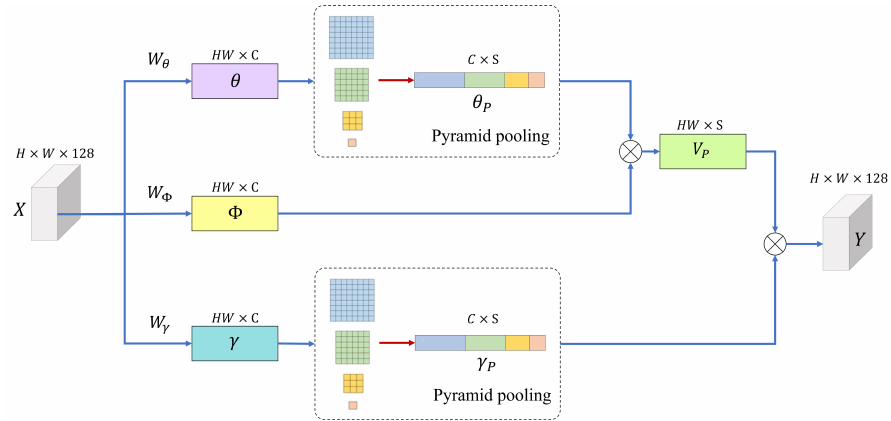
Figure 6. Structure of the asymmetric pyramidal non-local block with spatial pyramid pooling [88]. First, the input feature map X is converted to different embeddings, Φ , θ , and γ , respectively, through three 1 × 1 convolutions, W Φ , W θ and W γ